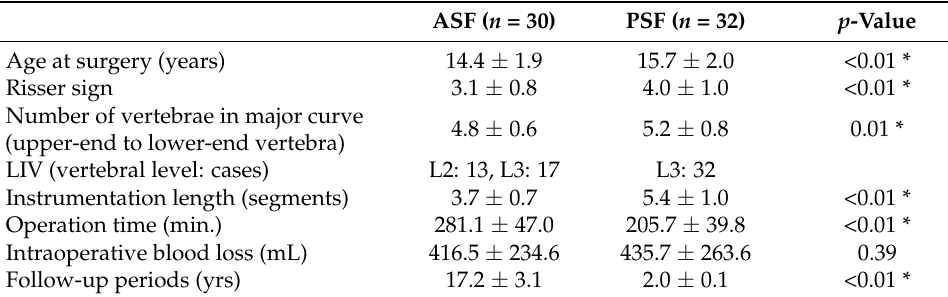
Table 1. Patient demographic data of ASF and PSF